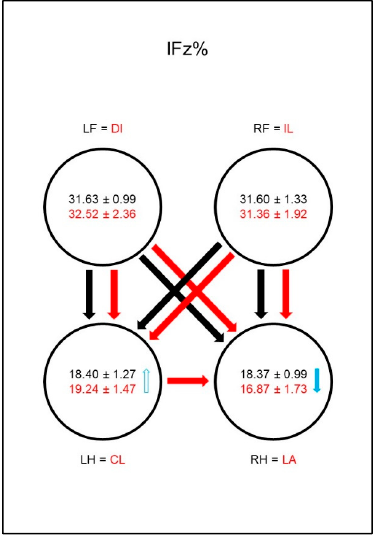
Figure 3. Vertical impulse as a percentage of total force (IFz%) in study group 1 and control group. For detailed explanation and abbreviations refer to Figure 2 (page 8).